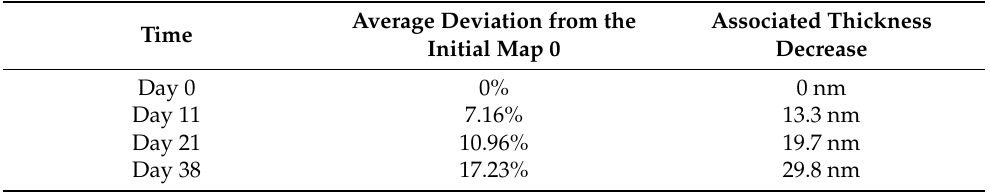
Figure 17. Theoretical reflectance variation as a function of thickness. An increase in R p indicates a thickness decrease compared to the nominal one. Table 3. Average differences for different days compared to the initial map (2 mm < Y < 10 mm) and associated thickness decreases.